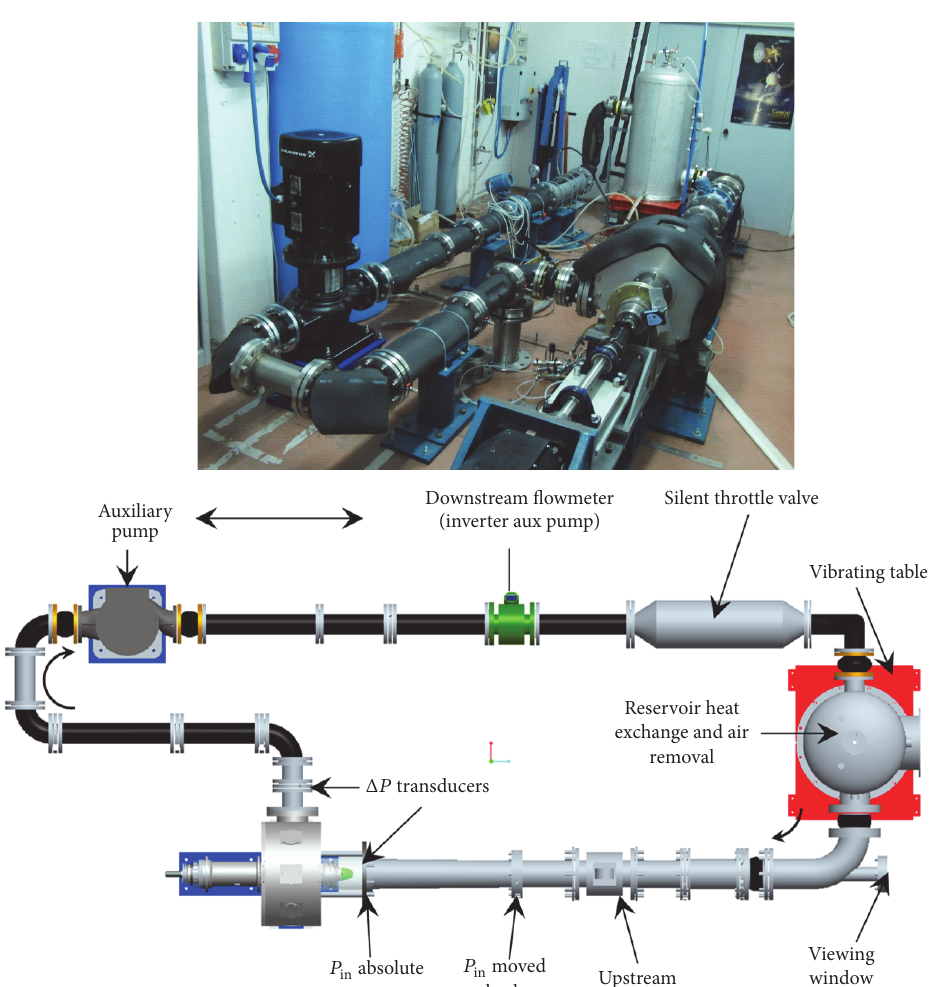
Figure 2: The Cavitating Pump Rotordynamic Test Facility and the experimental